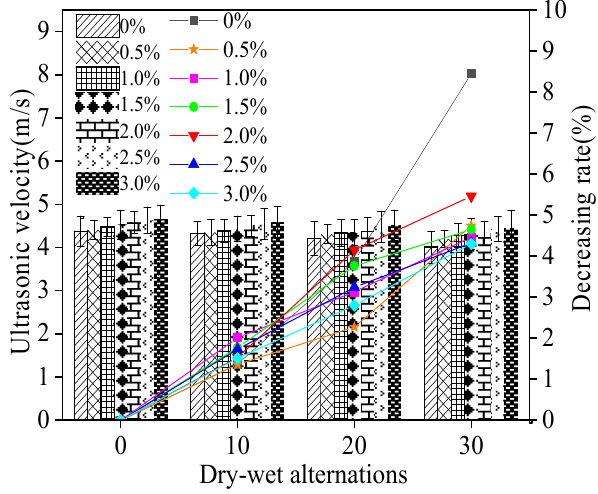
Figure 14. The ultrasonic velocity of MPC-RPC during NaCl D-W alternations.